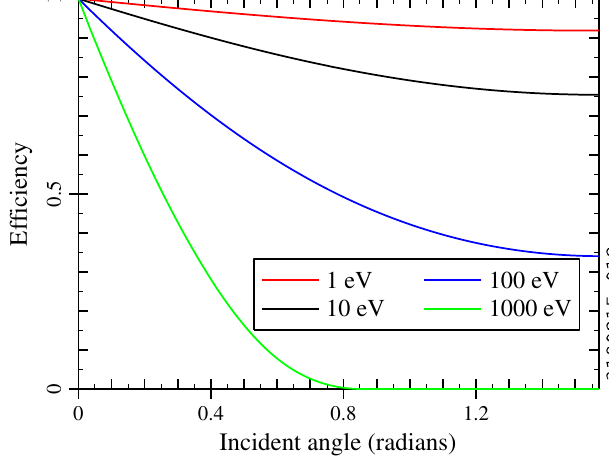
FIG. 9. Resonant spike location at different bunch spacings, 1 × 45 × 1 . 25 mA e þ , 5 GeV. Only the signal in the central collector is plotted.